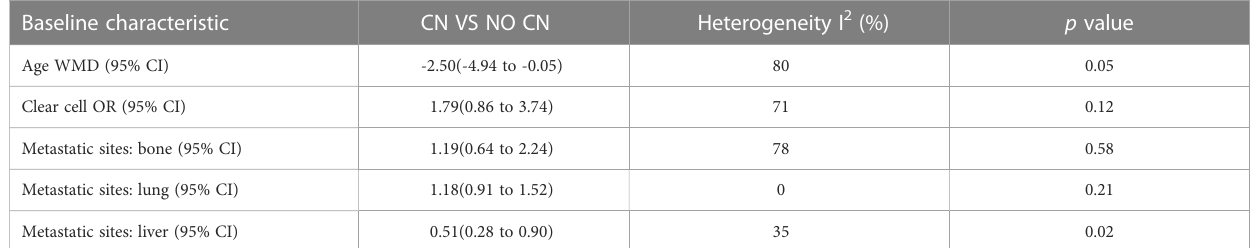
TABLE 3 Comparison of baseline